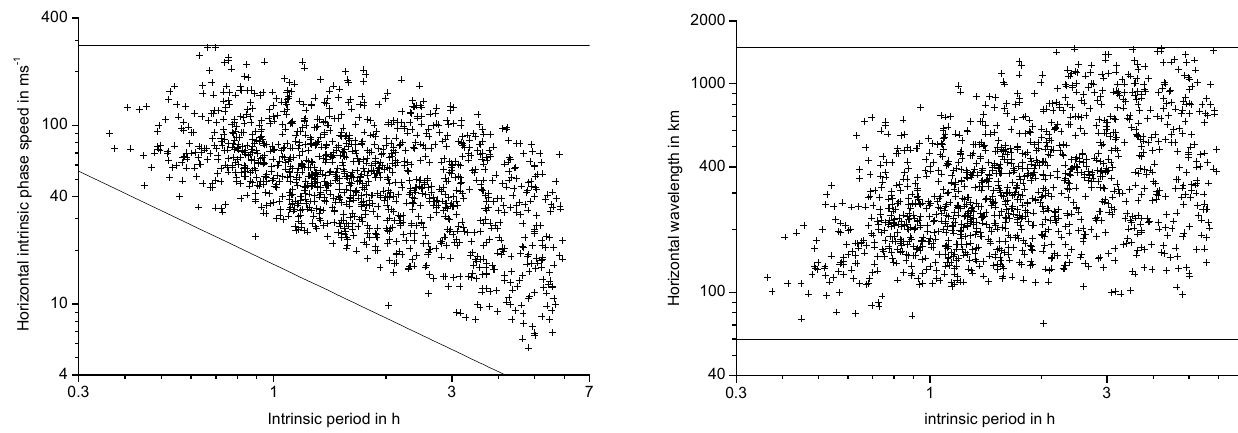
Fig. 8. Dependence of the horizontal phase velocity (left panel) and wavelength (right panel) of the IGW intrinsic period. System limits are given as straight lines.